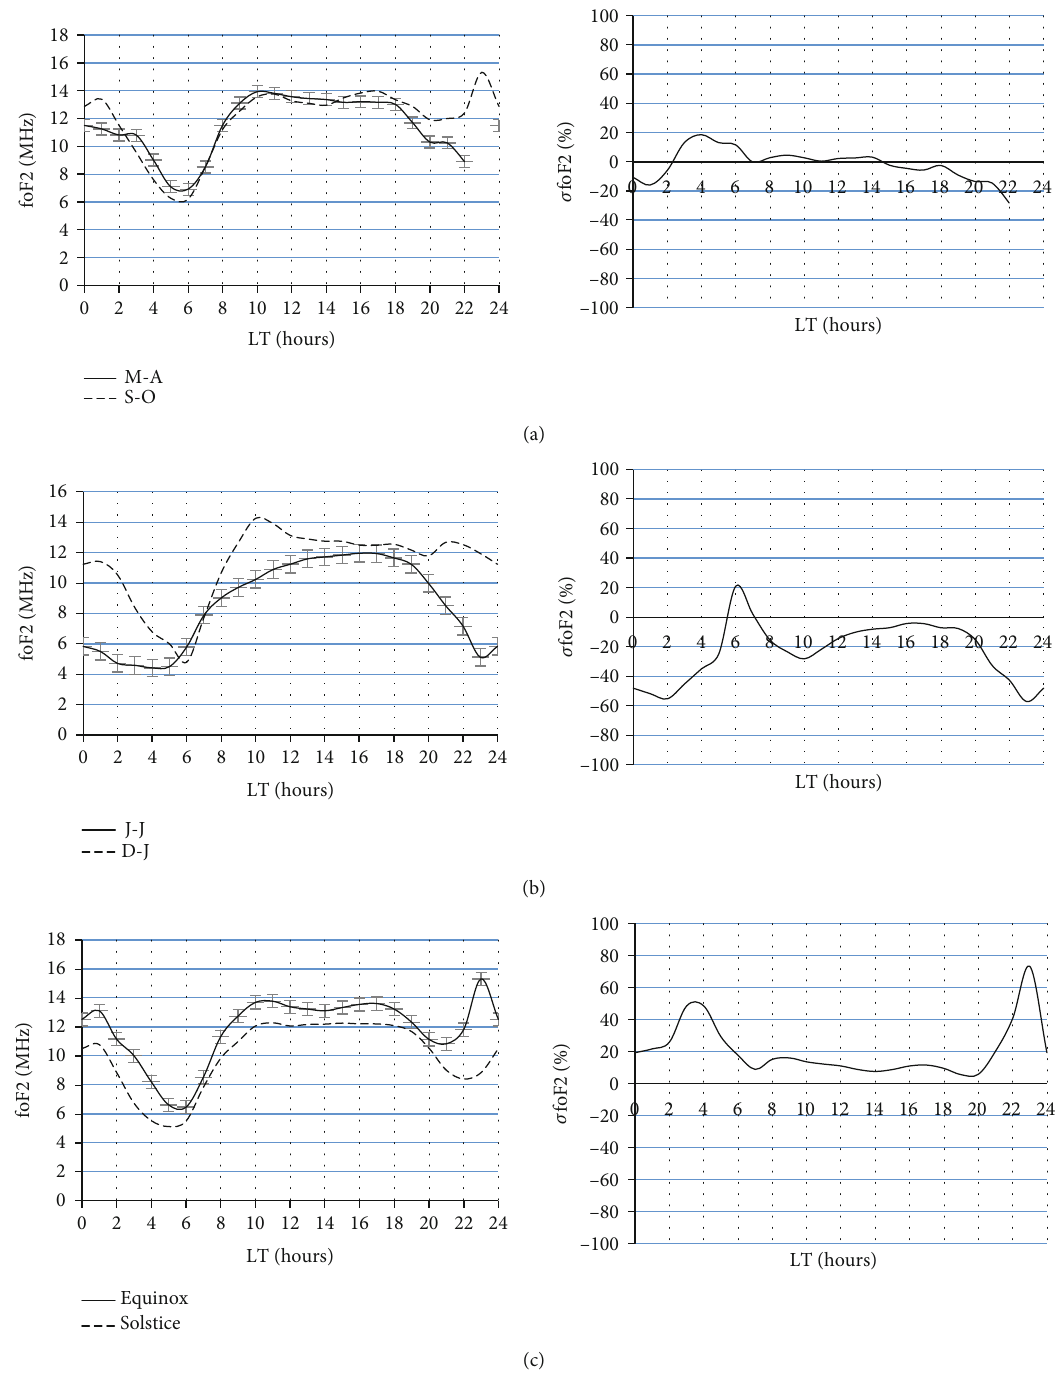
Figure 3: The same as Figure 1 but for the solar cycle maximum